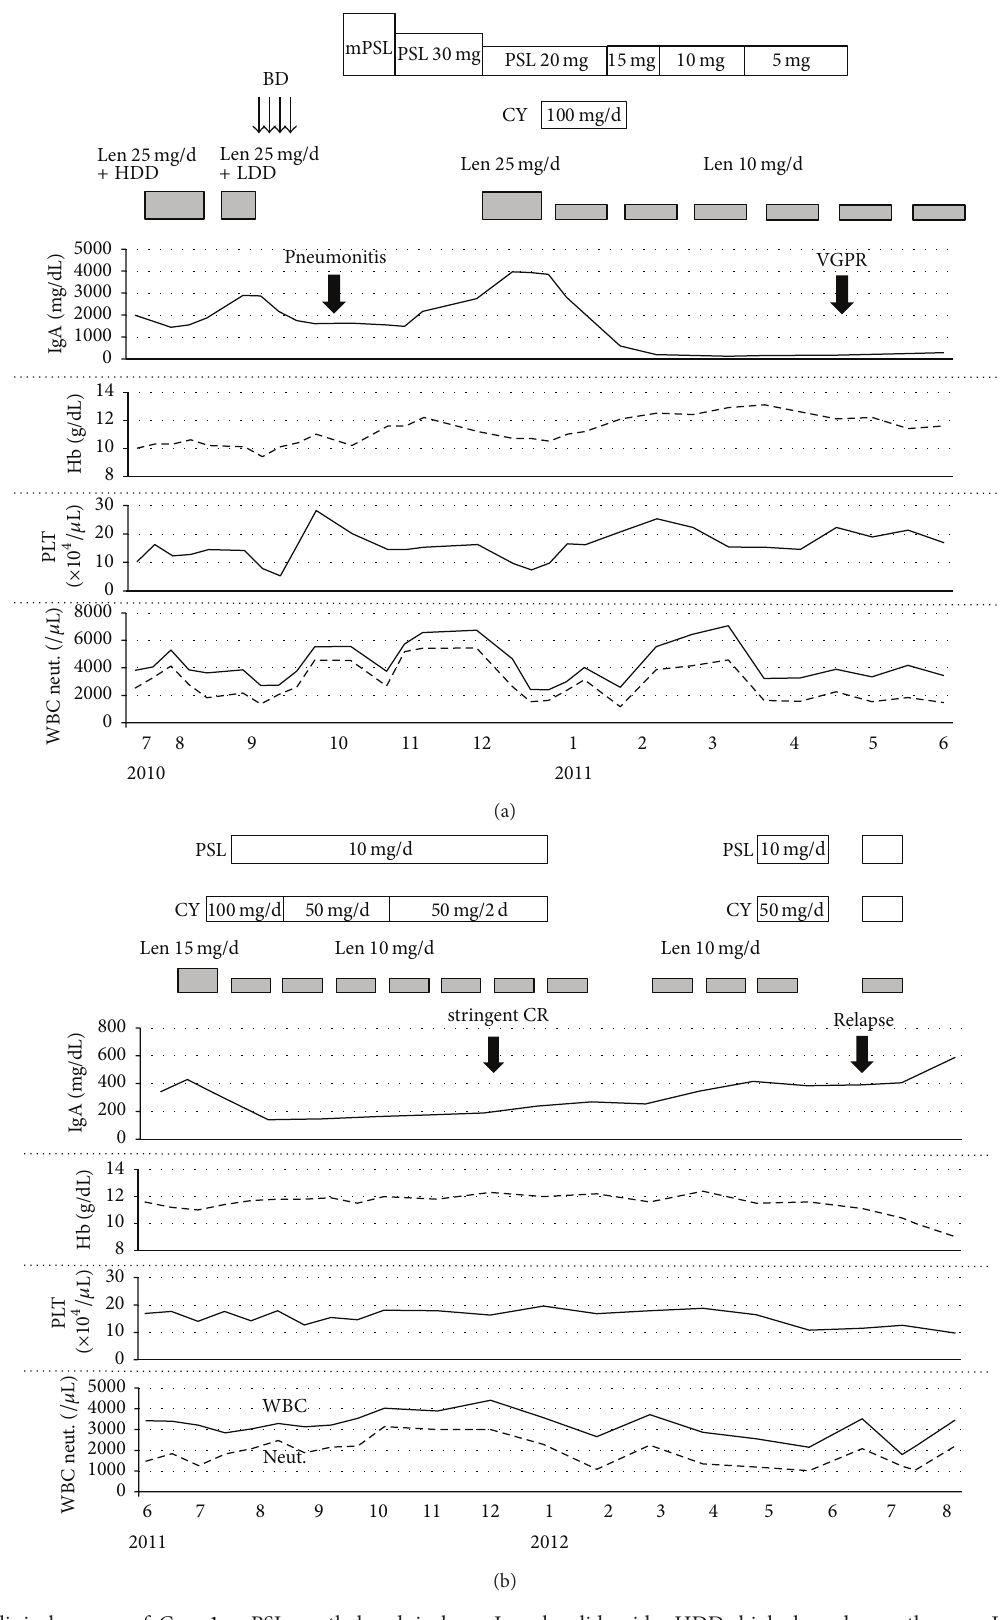
Figure 1: Clinical course of Case 1. mPSL: methylprednisolone; Len: lenalidomide; HDD: high-dose dexamethasone; LDD: low-dose dexamethasone; BD: bortezomib plus dexamethasone; CY: cyclophosphamide; Hb: hemoglobin; PLT: platelet counts; WBC: white blood cell counts; and neut.: neutrophil